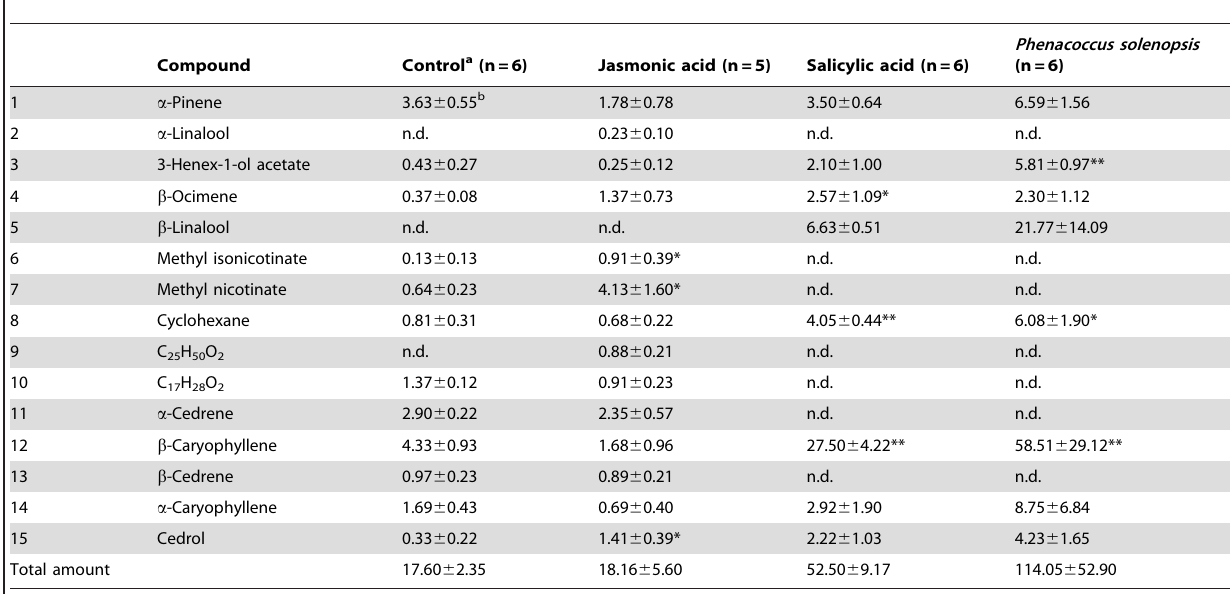
Table 2. Concentration (ng ? g FW 2 1 ? h 2 1 ) of volatile compounds detected in the headspace of cotton plants after different treatments.